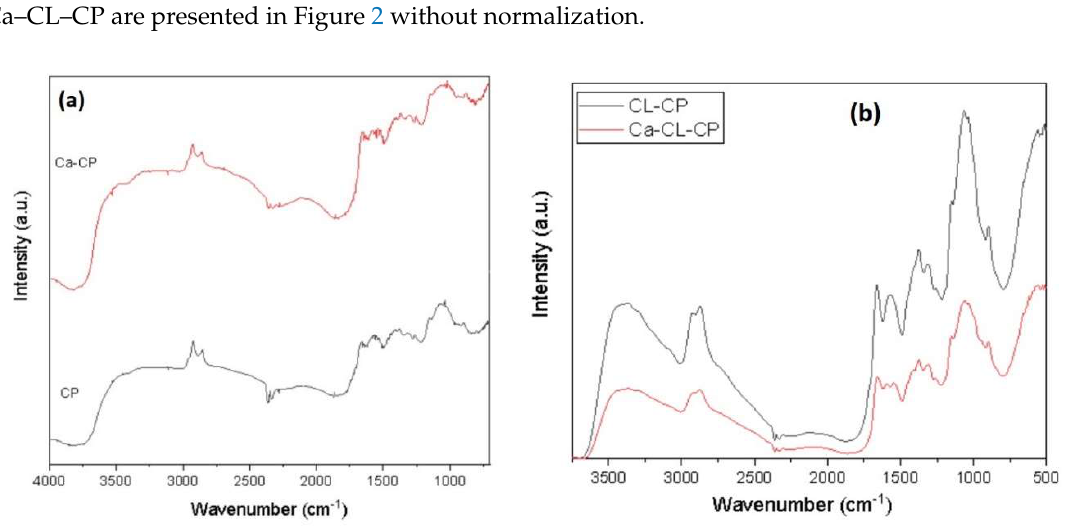
Figure 2. Fourier transform infrared (FTIR) spectra for pellets. ( a ) CP and Ca–CP, ( b ) CL–CP and Ca–CP.